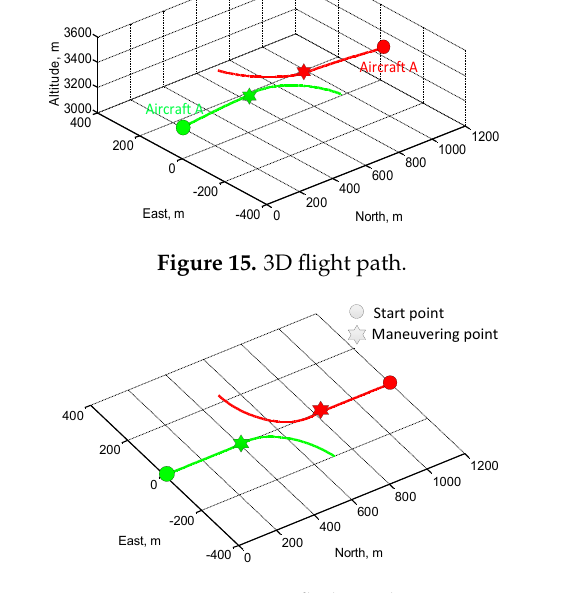
Figure 16. 2D flight path.